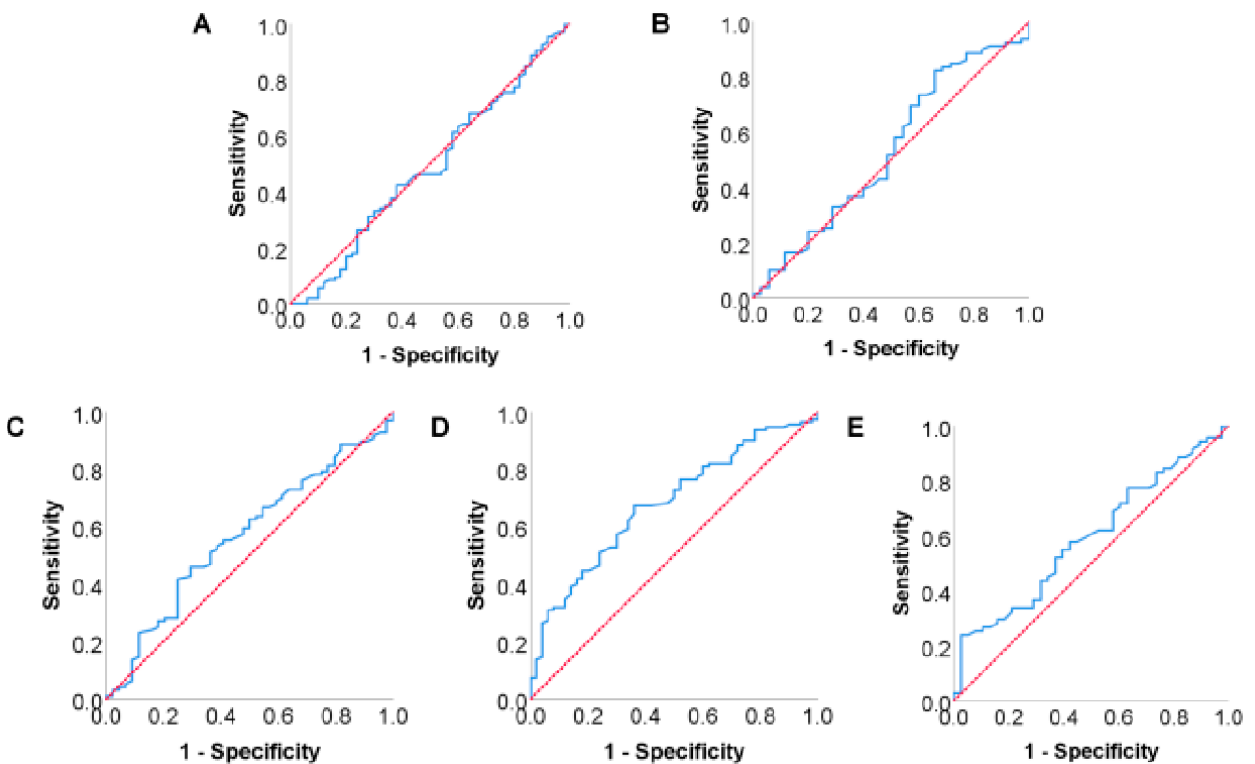
Figure 4. ROC curves between serum TC level at di ff erent time points and 1-year survival rate: ( A ) ROC curve between preoperative serum TC level and 1-year survival rate; ( B ) ROC curve between postoperative 3-day serum TC level and 1-year survival rate; ( C ) ROC curve between postoperative 1-week serum TC level and 1-year survival rate; ( D ) ROC curve between postoperative 4-week serum TC level and 1-year survival rate; ( E ) ROC curve between postoperative 8-week serum TC level and 1-year survival rate.